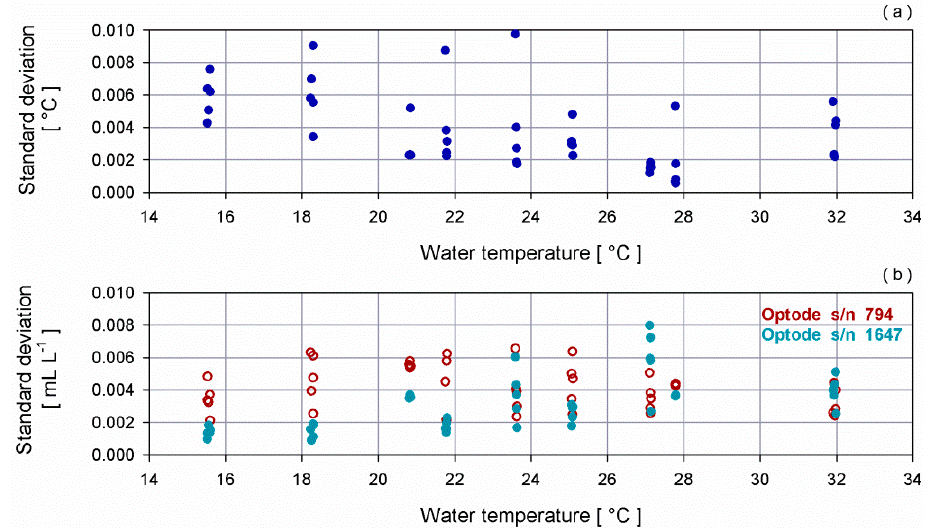
Figure 1. ( a ) Dispersion diagram between the temperature measured by the SBE35 and its standard deviation for each step; ( b ) dispersion diagram between the temperature measured by the SBE35 and the standard deviation of dissolved oxygen provided by optode s/n 794 (dark red empty dot) and optode s/n 1647 (dark cyan full